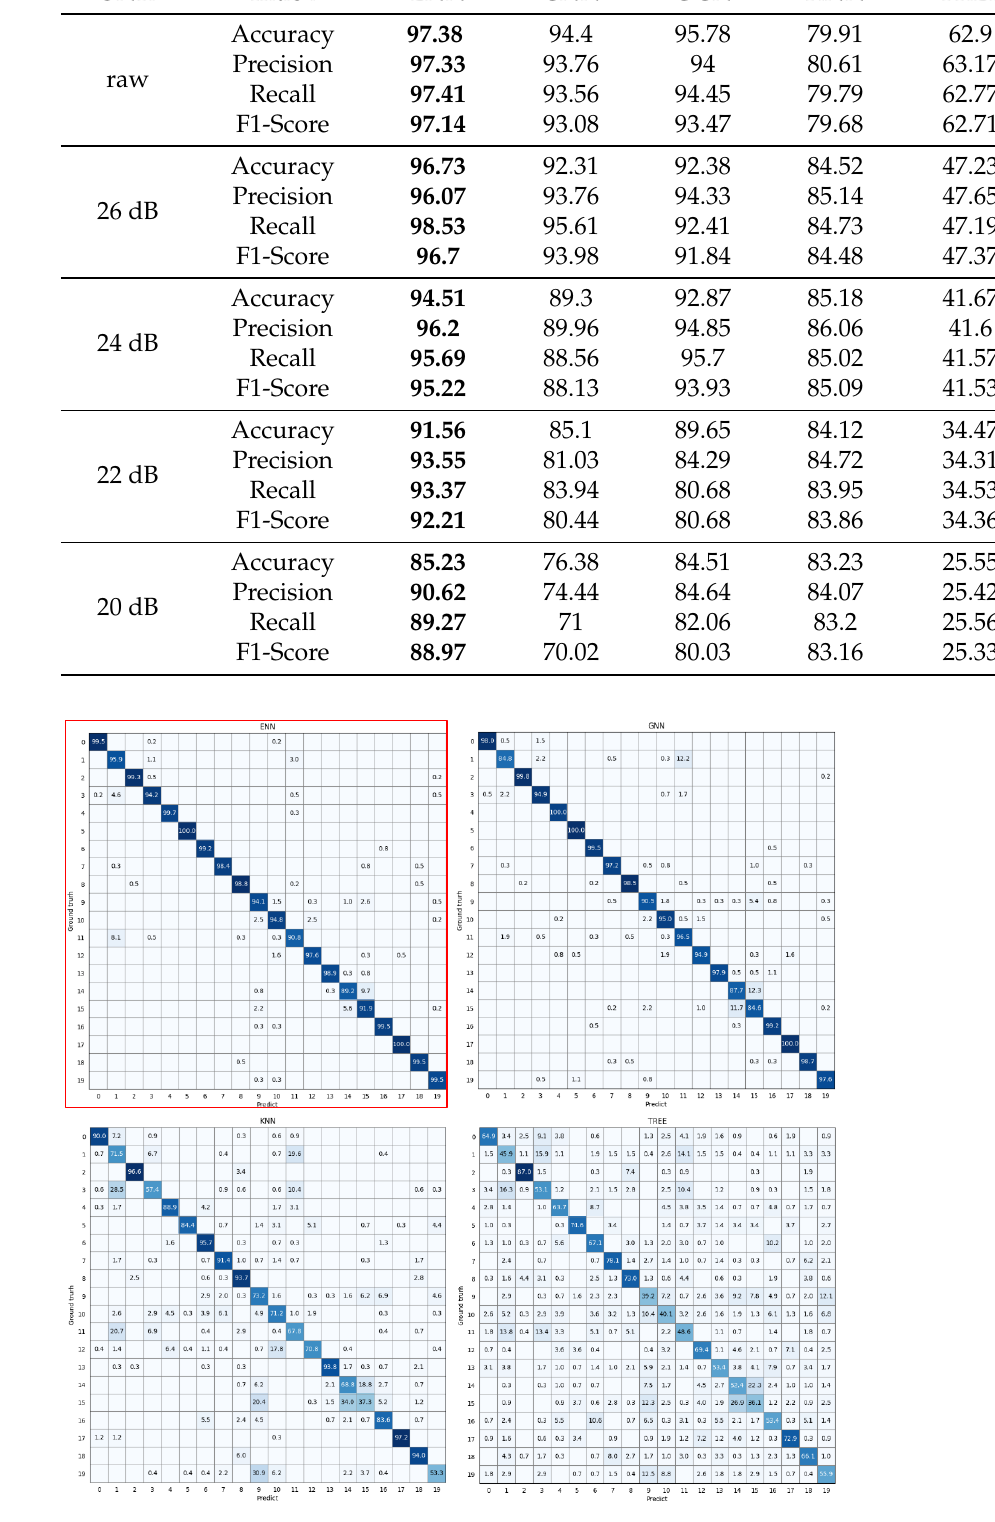
Figure 4. Confusion matrices of ENN and the comparison methods. The confusion matrix of our model has been highlighted with a red square. The stronger the blue color, the higher the classification